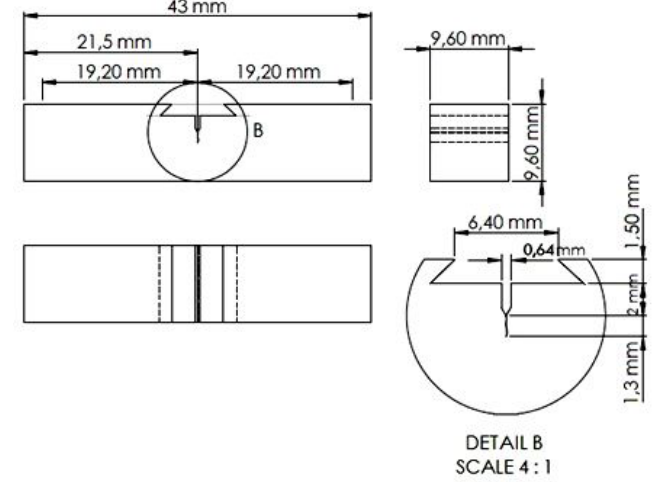
Figure 5. Single Edge Bend [SE(B)] specimen for the CTOD test. Table 5. Stress as a function of strain measured by strain gauges attached the HAZ.